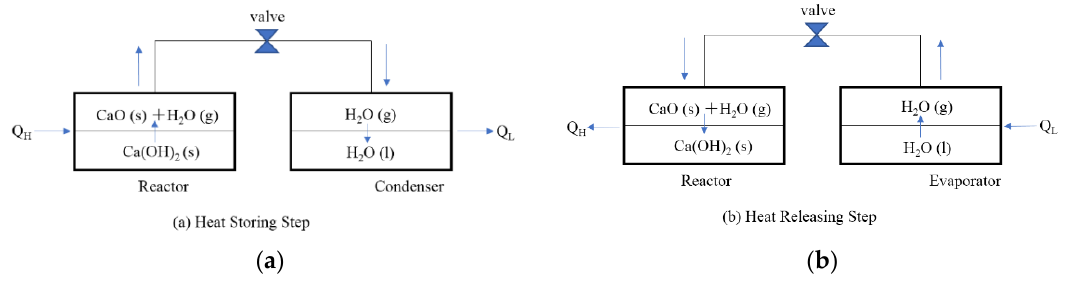
Figure 1. Operating principle of chemical heat pump. ( a ) Heat Storing Step ( b ) Heat Releasing Step.